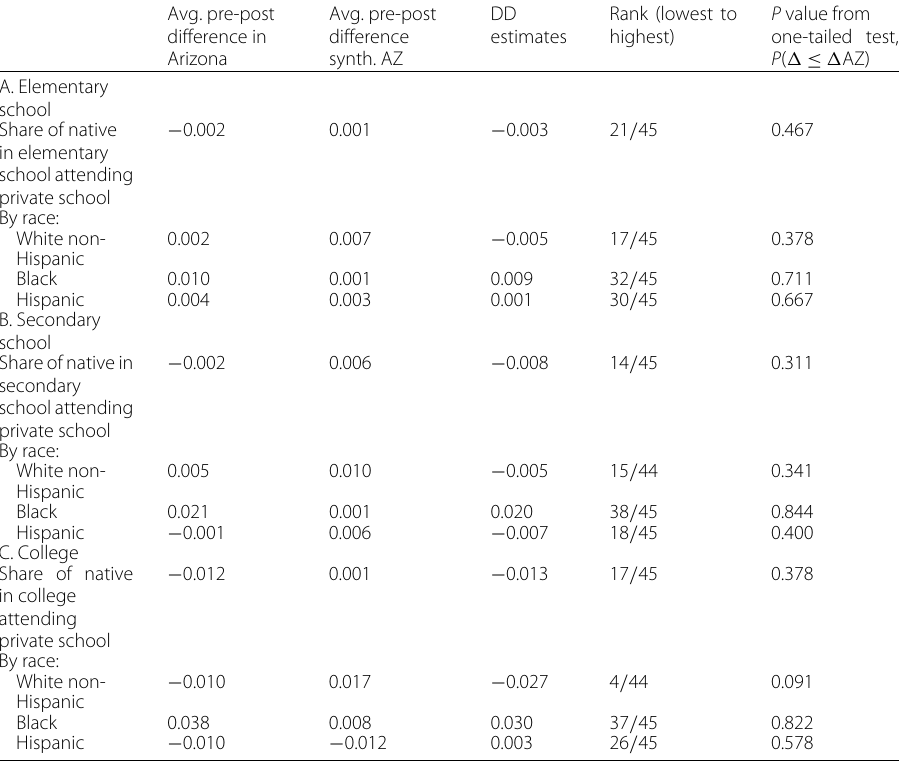
Table 3 LAWA and share of natives attending private school Avg. pre-post difference in